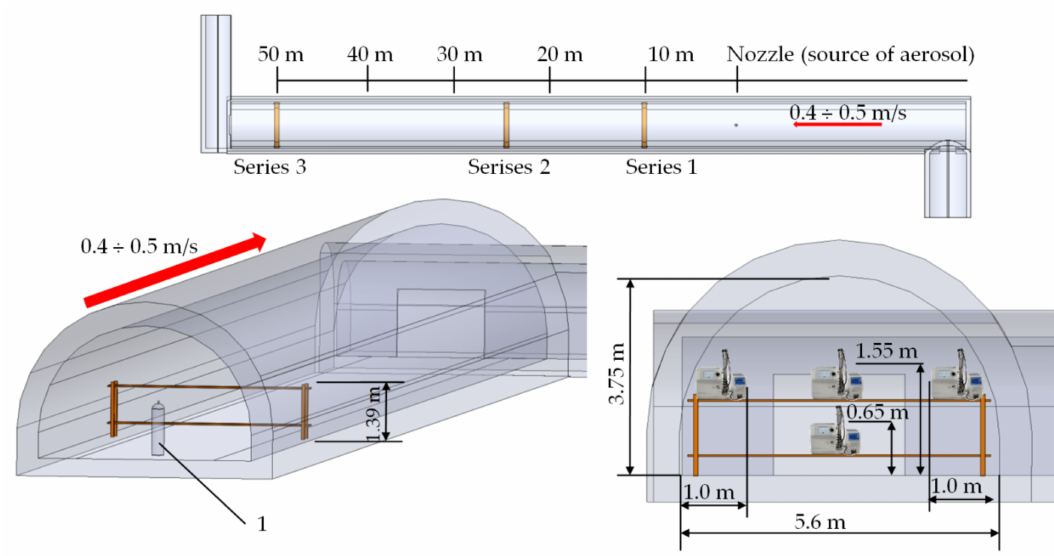
Figure 2. Schematic diagram of the laboratory rig and the aerosol measurement manner in the experimental part of the underground excavation: 1—nozzle (source of aerosol).